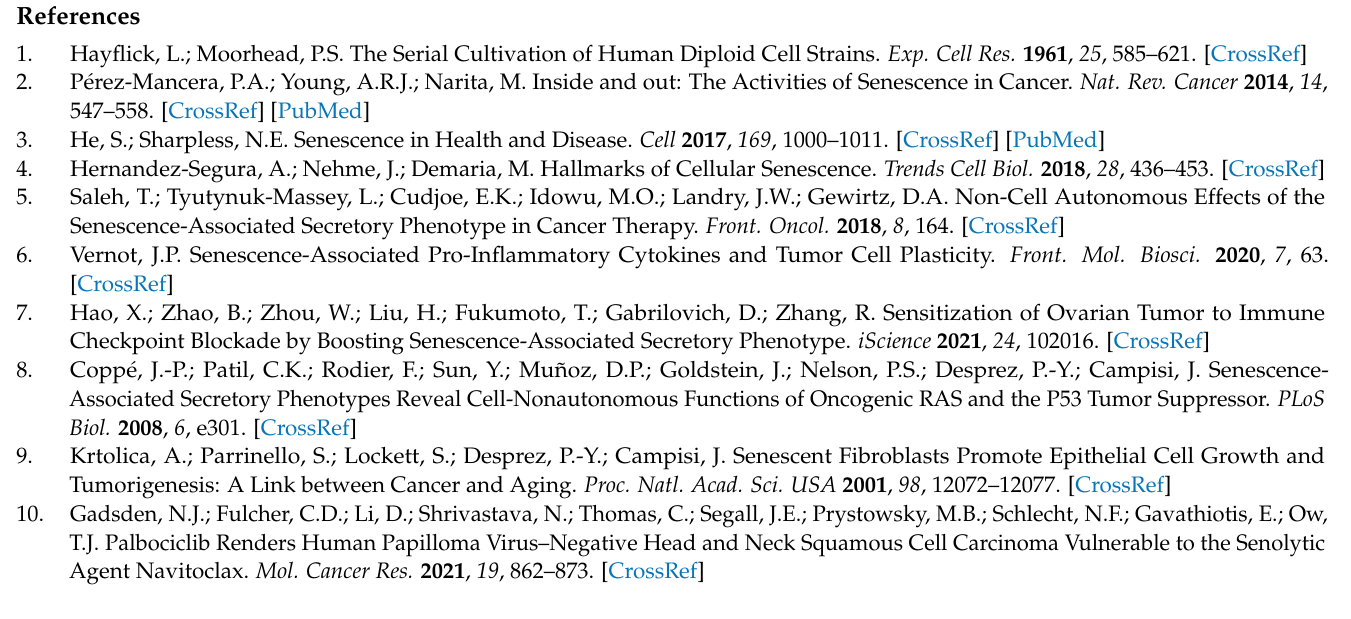
Figure S1: Characterization of AKT1 clones. Figure S2: NT and AKT1 clones display similar senes- cence phenotypes. Figure S3: Effect of Palbociclib on cGAS and STING. Figure S4: Ru521 and H151 are functional. Figure S5: AKT1 knockout impairs NF- κ B signaling. The uncropped blots are shown in Supplementary